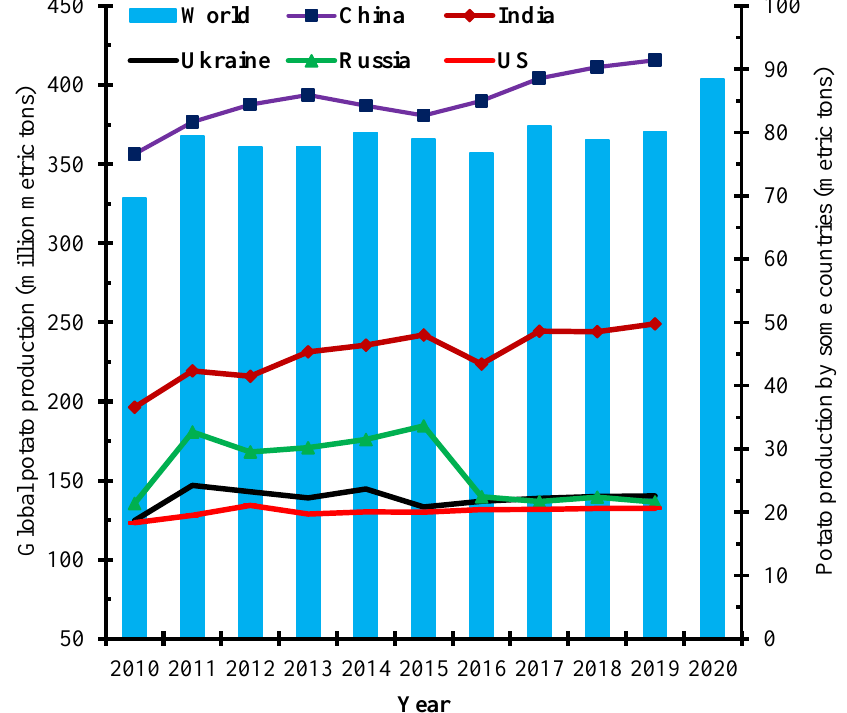
Figure 2. Global potato production (2010–2020) and potato production by top five countries (2010–2019) (secondary y-axis). Compiled by the authors from [14,15].